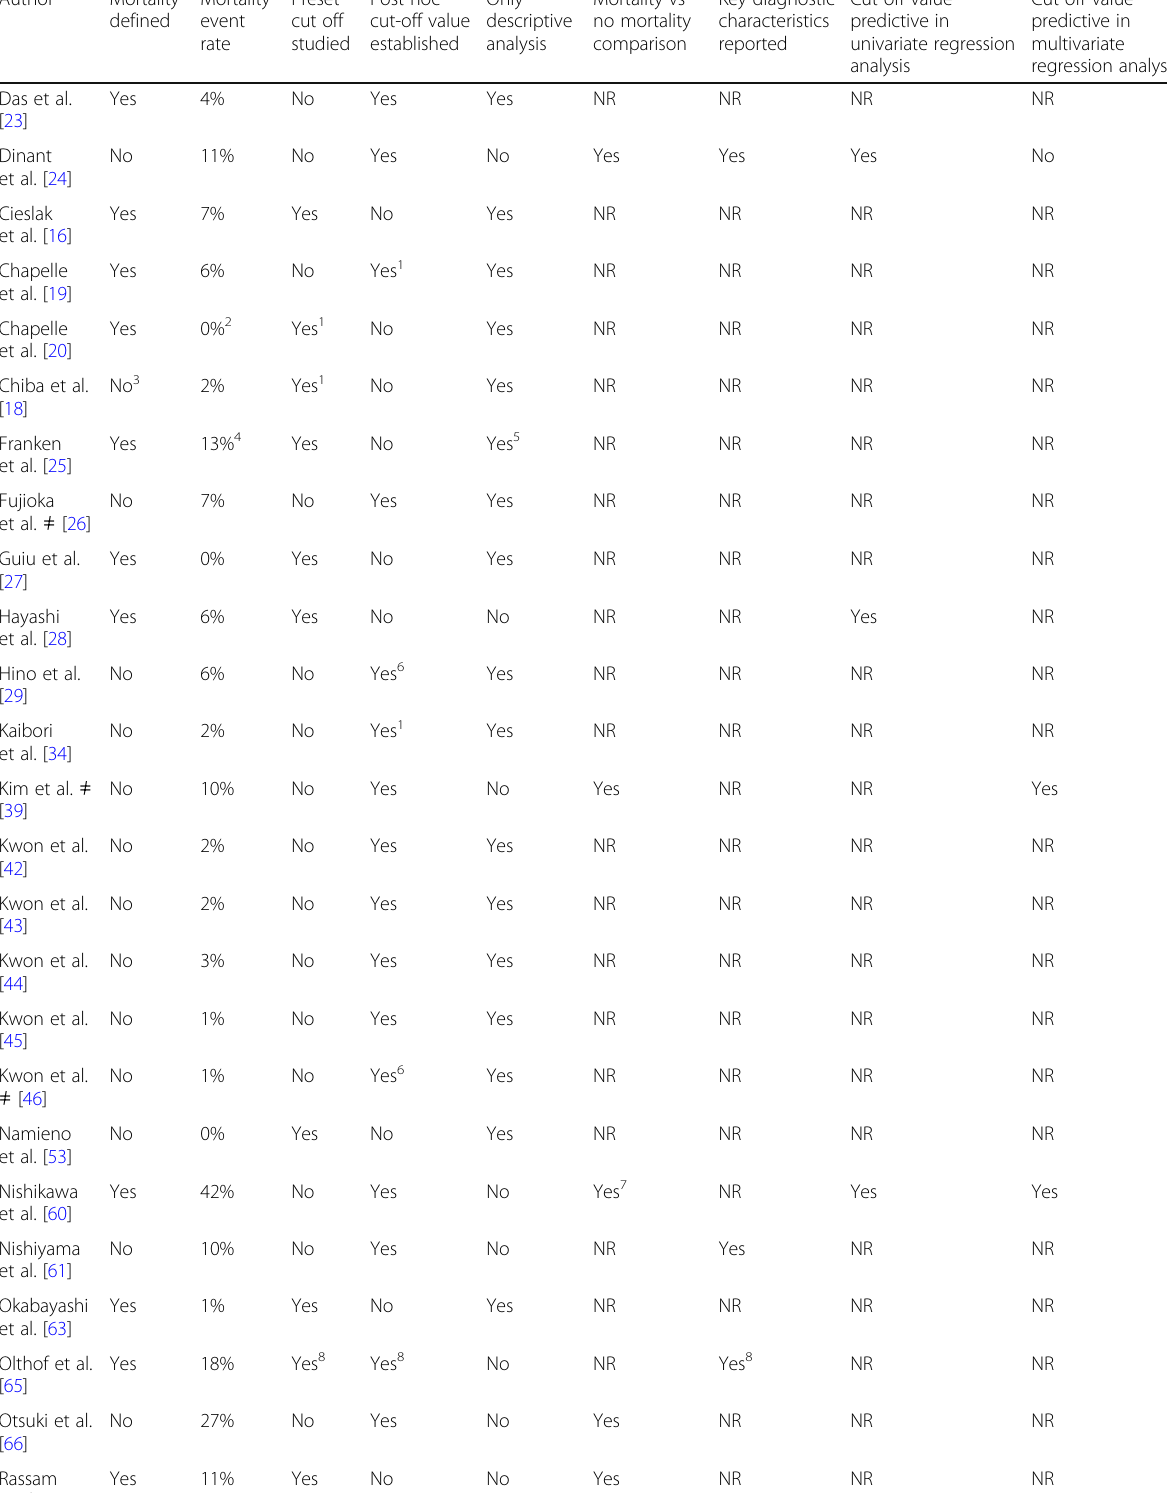
Table 2 Overview of trials reporting on the correlation between a preoperative nuclear imaging examination and postoperative